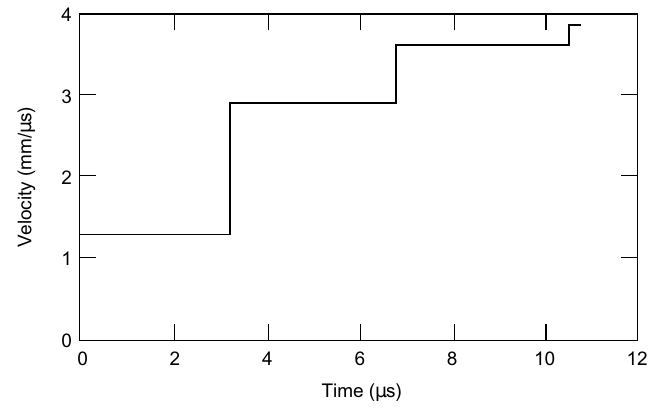
Fig. 4. Velocity versus time of loaded surface of aluminum plate interacting with